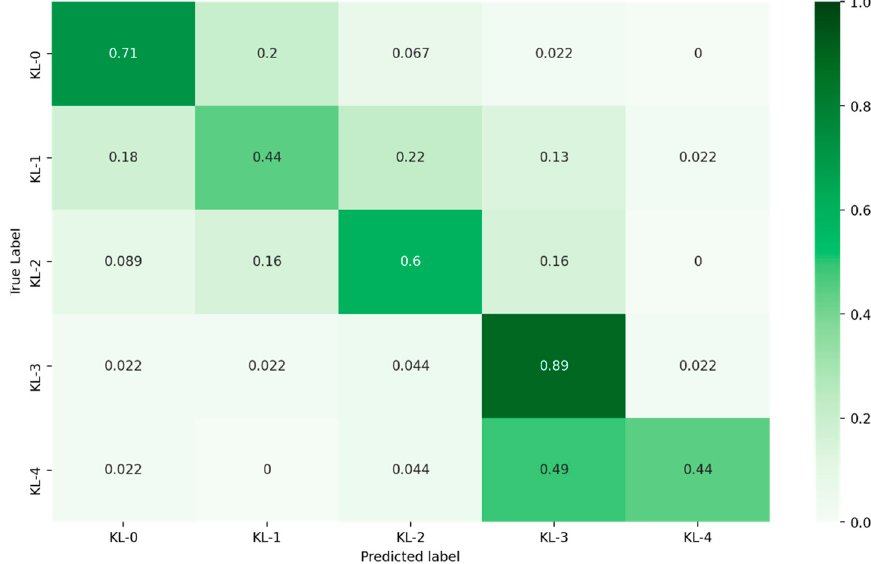
Figure 4. Confusion matrix for KL grading according to the proposed model. Table 2. Summary of TP, FP, and FN values for each KL class.